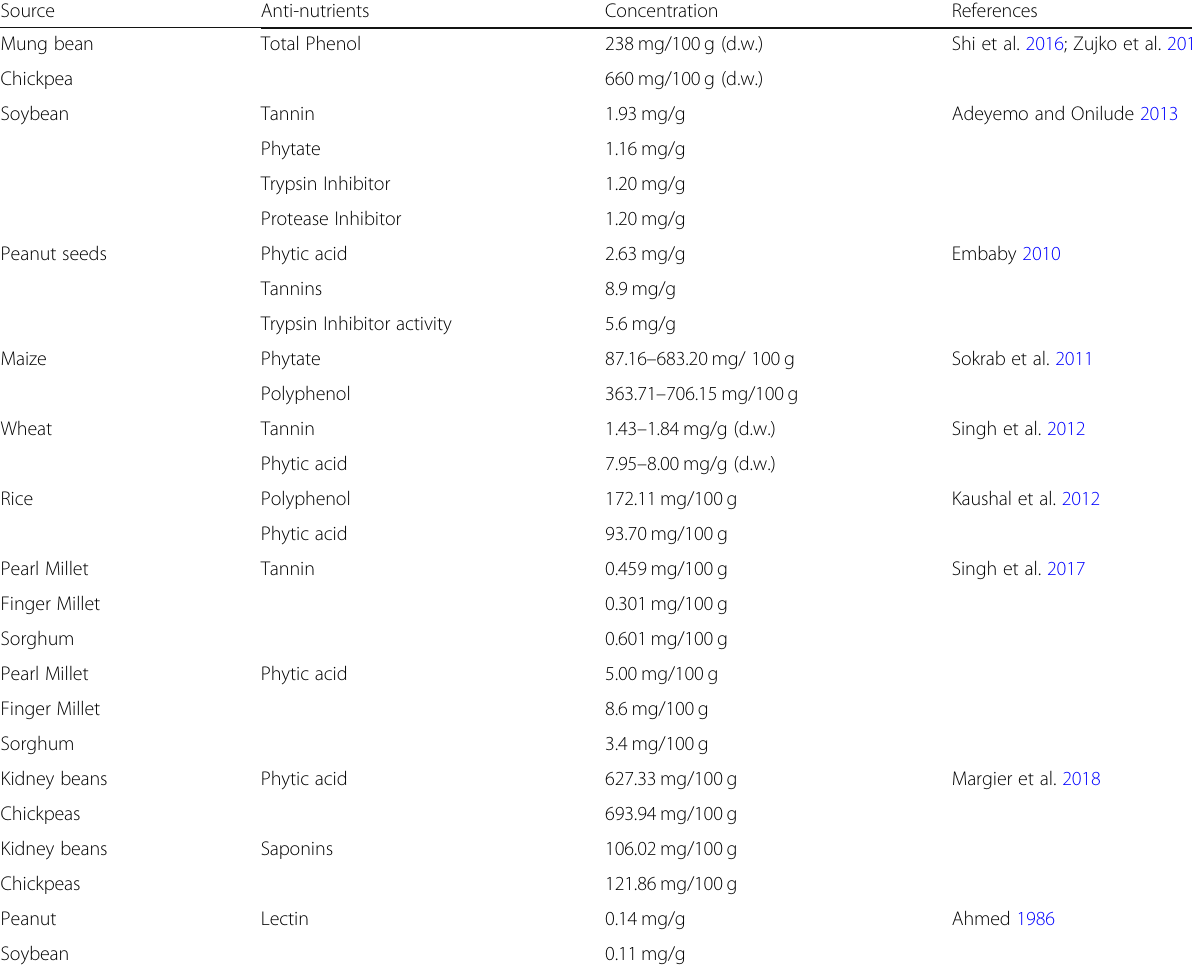
Table 1 Anti-nutrients and their concentrations in different food